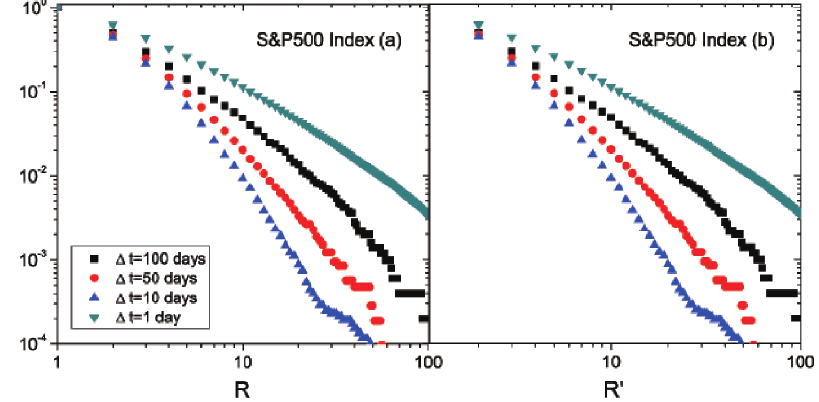
Figure 3. CDFs of (a) R and (b) R 9 for different time intervals, D T , for the S&P500 Index in the US stock market. Each curve can be fitted with a power law, as indicated by the straight line in the log-log plot. Regarding the fitting, more details are listed in Table 2.